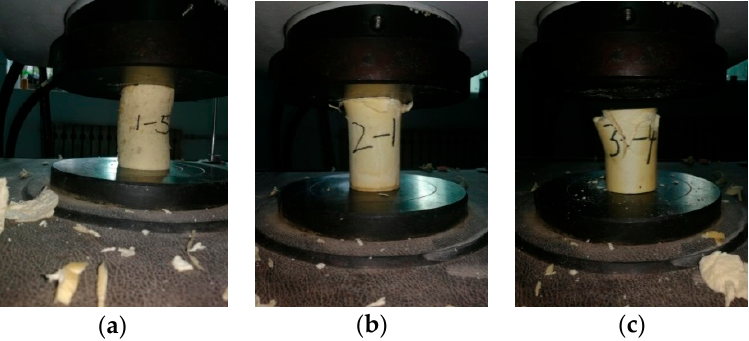
Figure 5. Typical failure modes of specimens. ( a ) The density is 0.235 g / cm; ( b ) The density was 0.286 g / cm 3 ; ( c ) The density is 0.323 g / cm 3 .